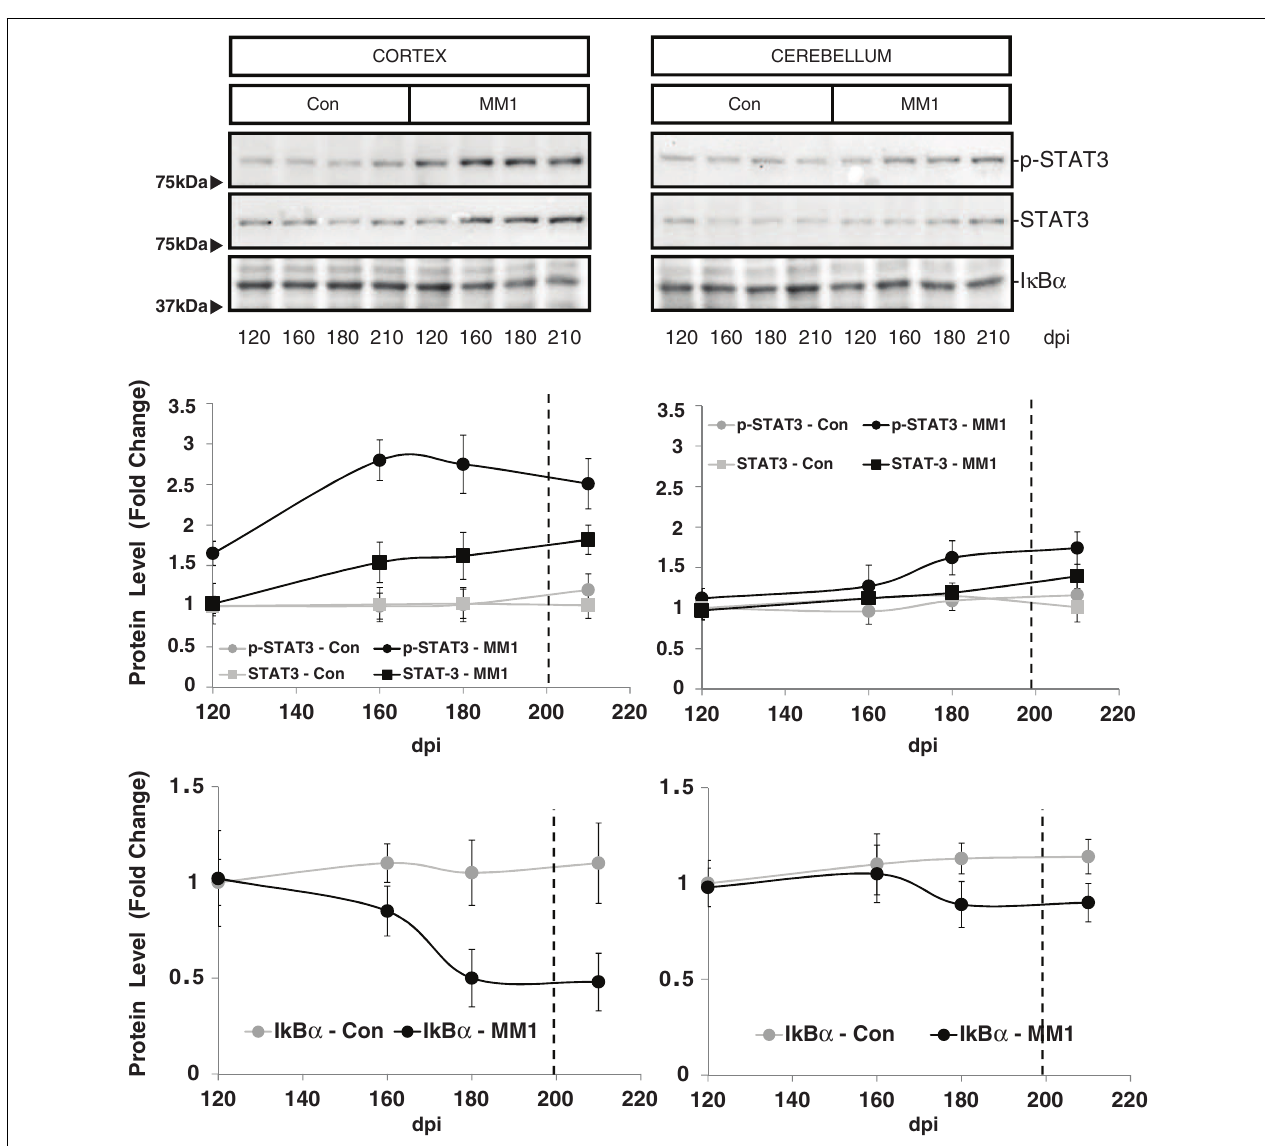
FIGURE 7 | Region-specific cell signaling in sCJD MM1 mice is shown .Western blot analysis of p-STAT3, STAT3 and I κ B α levels in the cerebral cortex and cerebellum of control and sCJD MM1 mice at different dpi. Densitometry values of three animals/time point are shown.